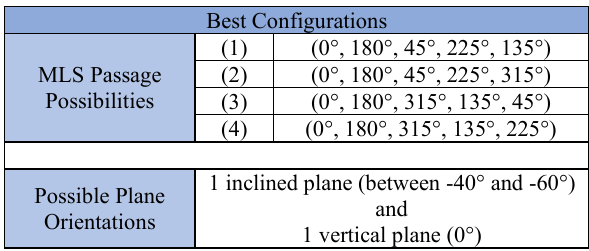
Table 3 – Best configurations for all systematic errors